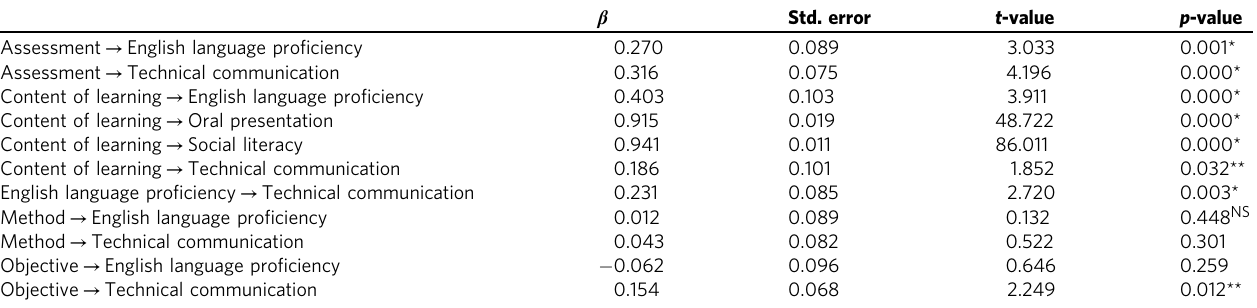
Table 14 Signi fi cance of relationships for the structural model.